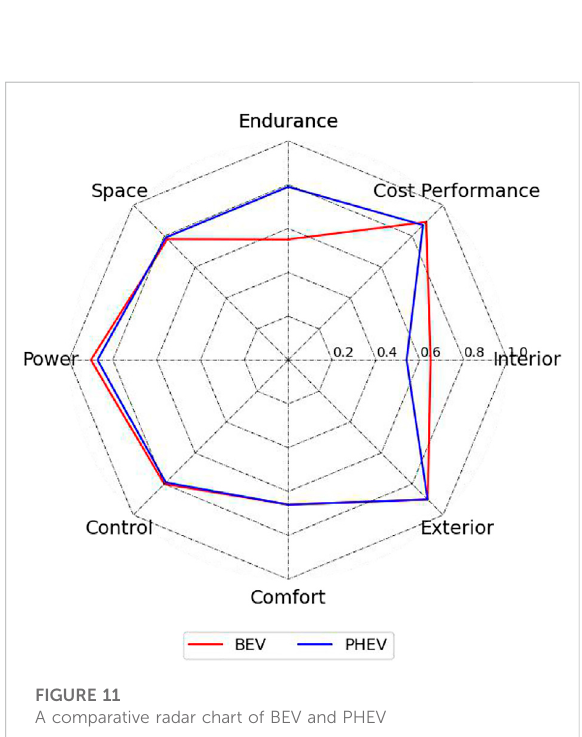
FIGURE 11 A comparative radar chart of BEV and